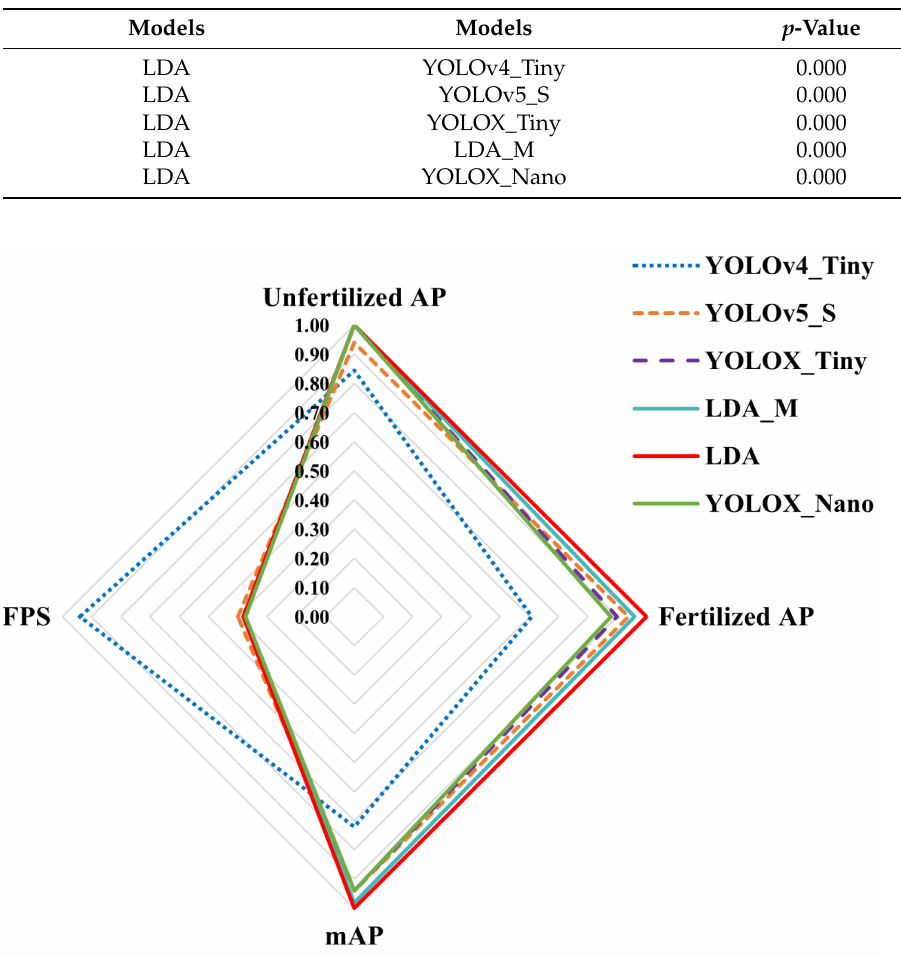
Figure 7. Accuracy of using different methods to detect the fertility status of breeding